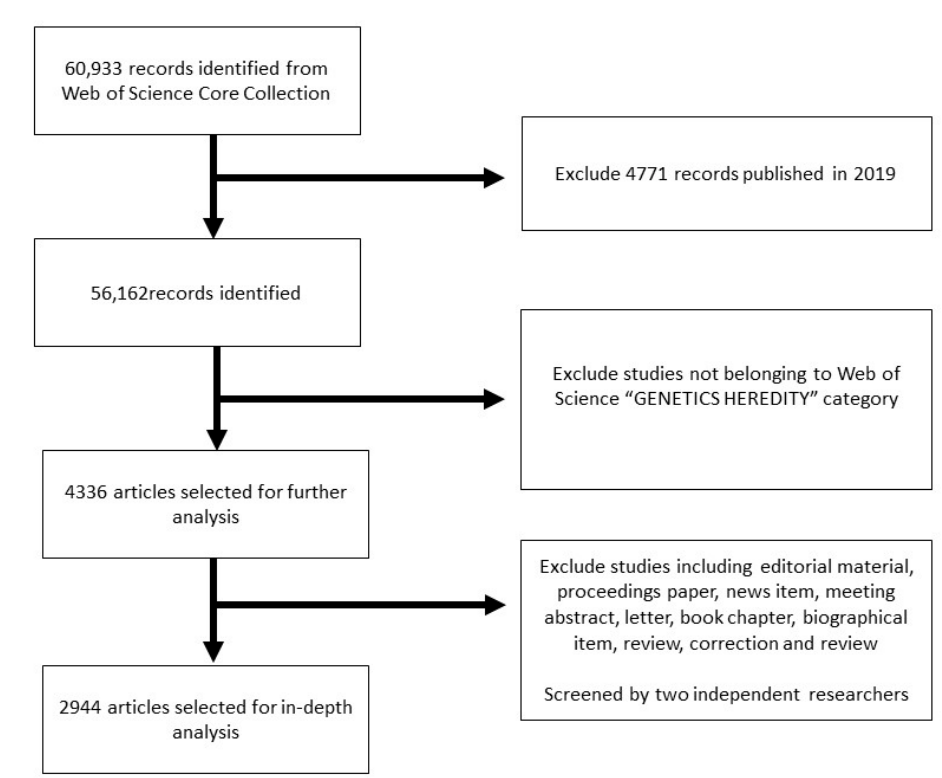
Figure 1. The flow chart of the methodology.